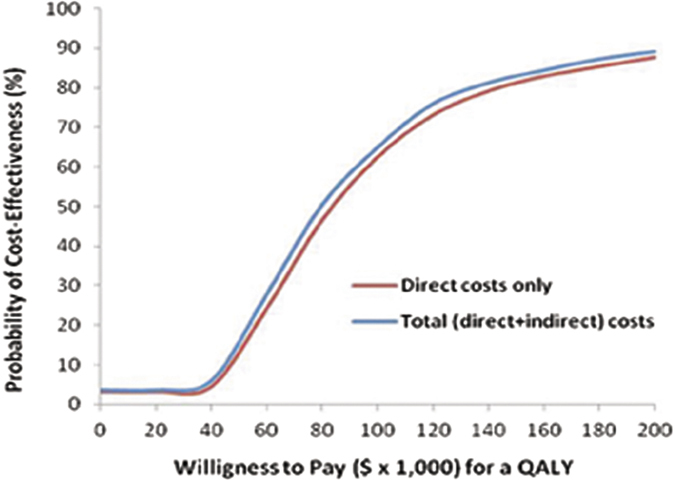
Acceptability curves of radiofrequency ablation (RFA) compared with open thyroidectomy (OT).Cost effectiveness acceptability curve using the net–monetary benefit approach (10,000 bootstrap replications) represents the probability (y-axis) that RFA is more cost effective compared with OT at the range of willingness-to-pay thresholds (US$ per quality-adjusted life-year [QALY]) on the x-axis. The curve is generated by repeating the procedure for various thresholds, with the threshold on x-axis and the probability of RFA to be cost effective on y-axis. Acceptability curves are presented here taking into account direct costs only or total (direct and indirect) costs.